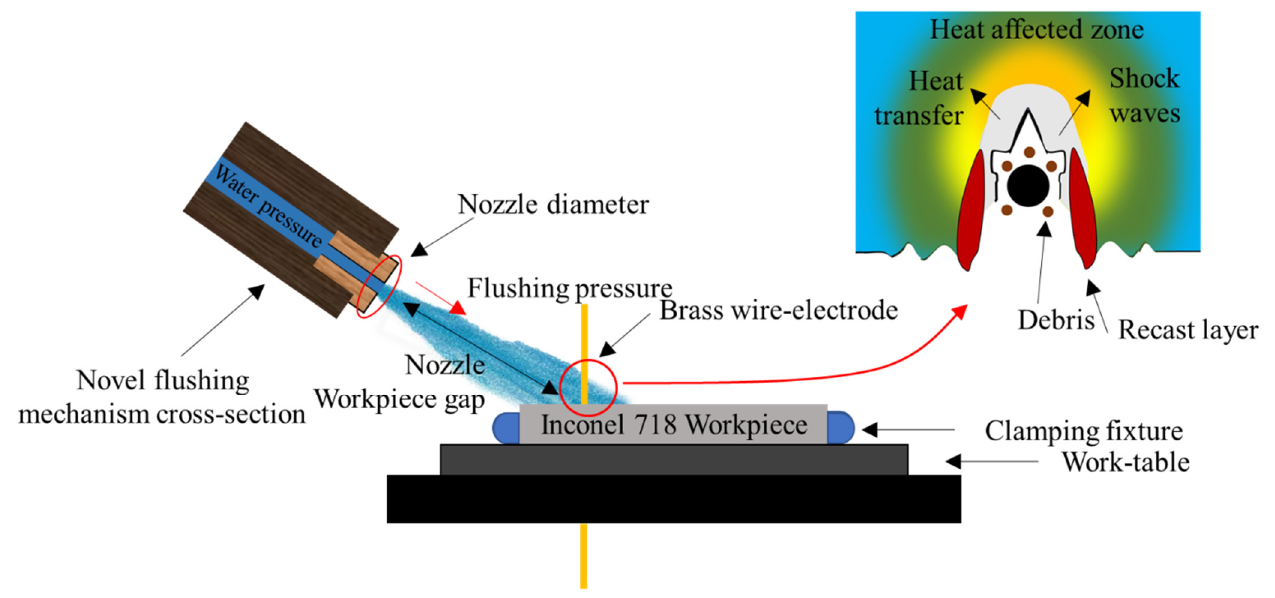
Figure 4. A novel flushing mechanism applied to the wire electric discharge machining process ([25] modified with permission from Springer).